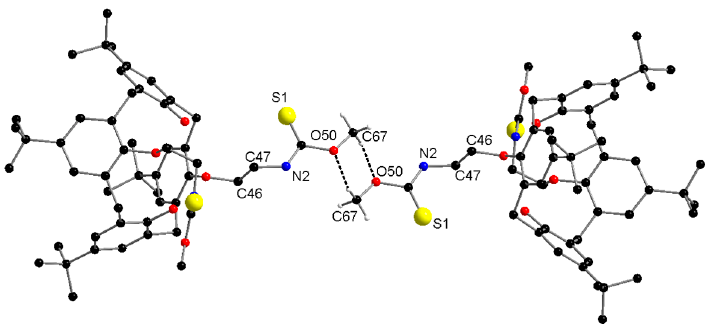
Figure 4. Dimers of compound ( 4 ). The methanol solvent molecule and H atoms not involved in the intermolecular interactions have been omitted for clarity.